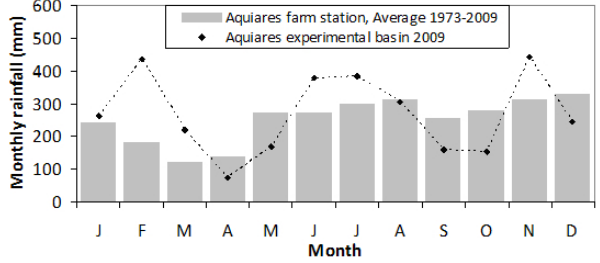
Fig. 2. Mean monthly rainfall at Aquiares farm station